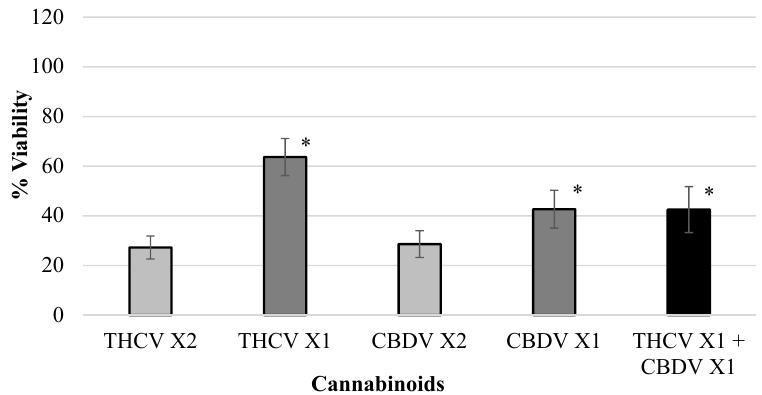
Figure 7. Viability of polyp cells exposed to THCV and CBDV. The cannabinoid combination THCV + CBDV had no synergistic effect (* p > 5, Bliss equation calculation = − 0.15). Legend: tetrahydrocannabivarin (THCV), cannabidivarin (CBDV).